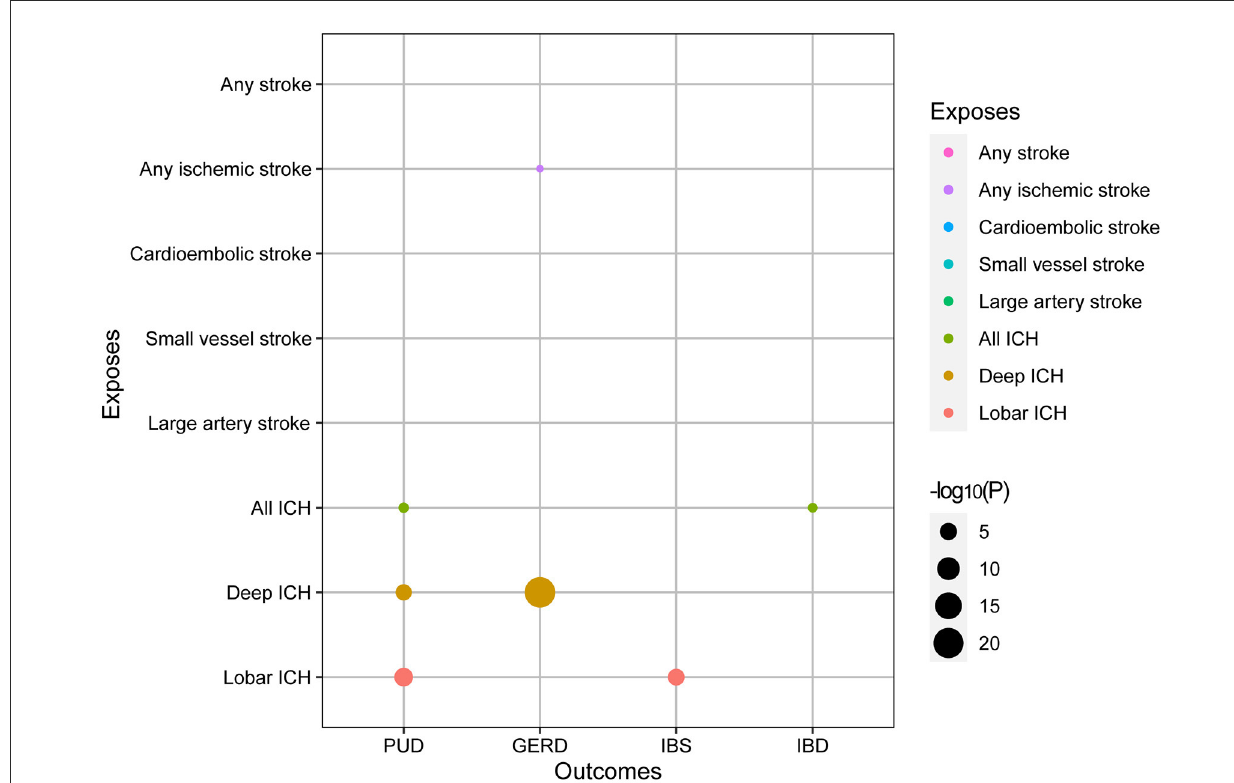
FIGURE2 Bubble plot of MR study of stroke on gastrointestinal disorders derived from IVW.